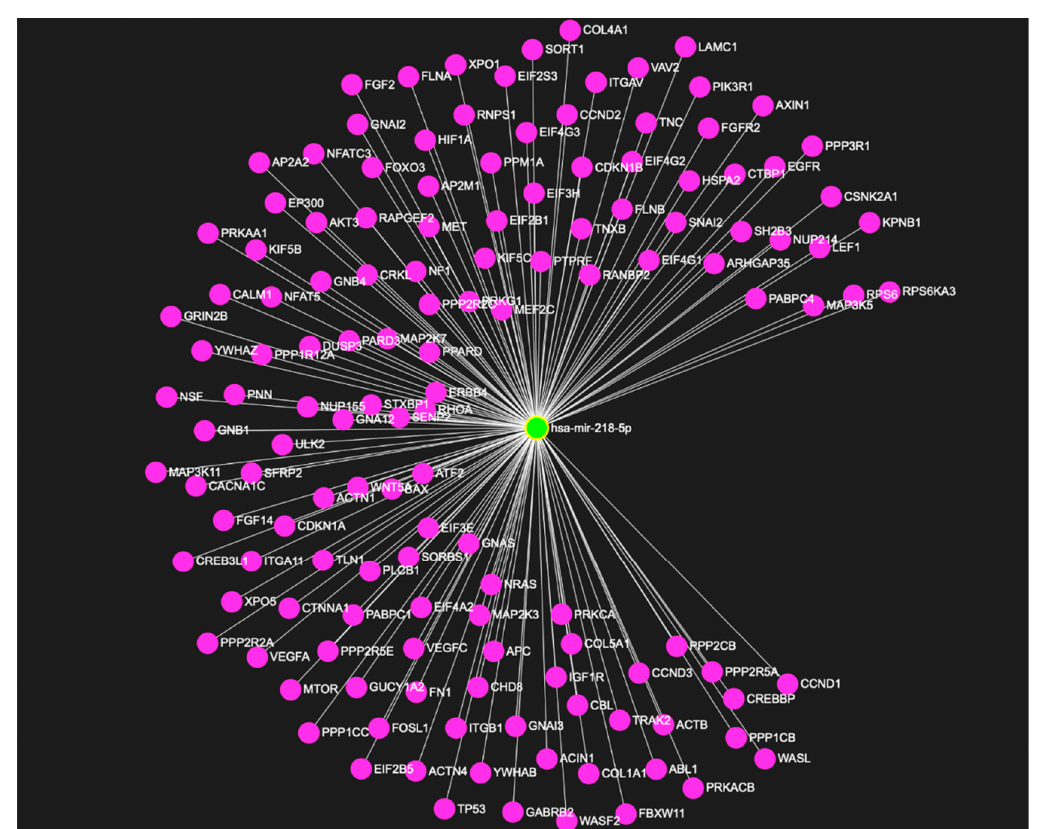
Figure 3. MiR-218-5p as a center of a diverse target gene-regulatory network enriched in the brain. The figure shows the regulation of various genes targeted by miR-218-5p.